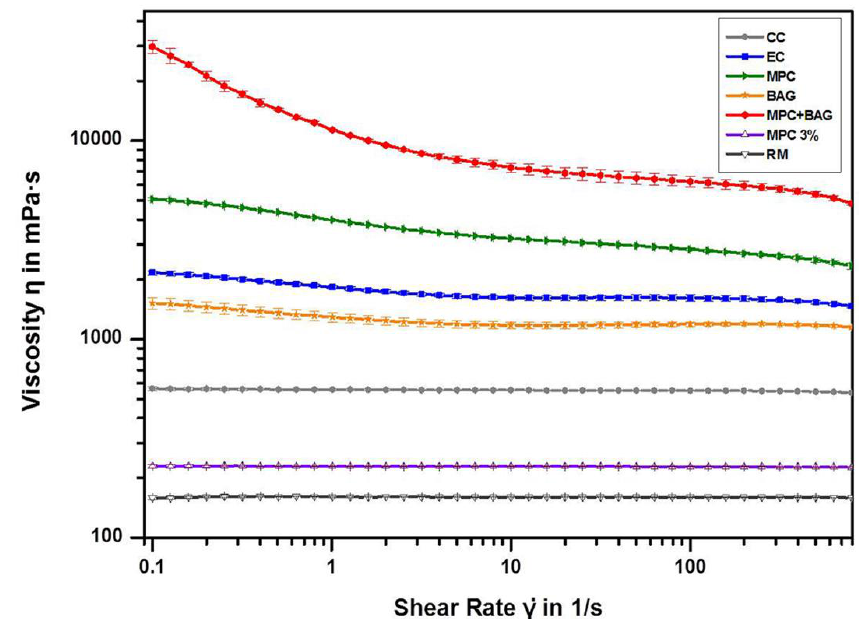
Figure 2. Viscosity of the groups: Commercial control (CC), experimental control of 50 wt% resin matrix + 50 wt% glass filler (EC), 48.5 wt% resin matrix + 48.5 wt% glass filler + 3 wt% MPC (MPC), 50 wt% resin matrix + 37.5 wt% glass filler + 12.5 wt% BAG (BAG), 48.5 wt% resin matrix + 36.38 wt% glass